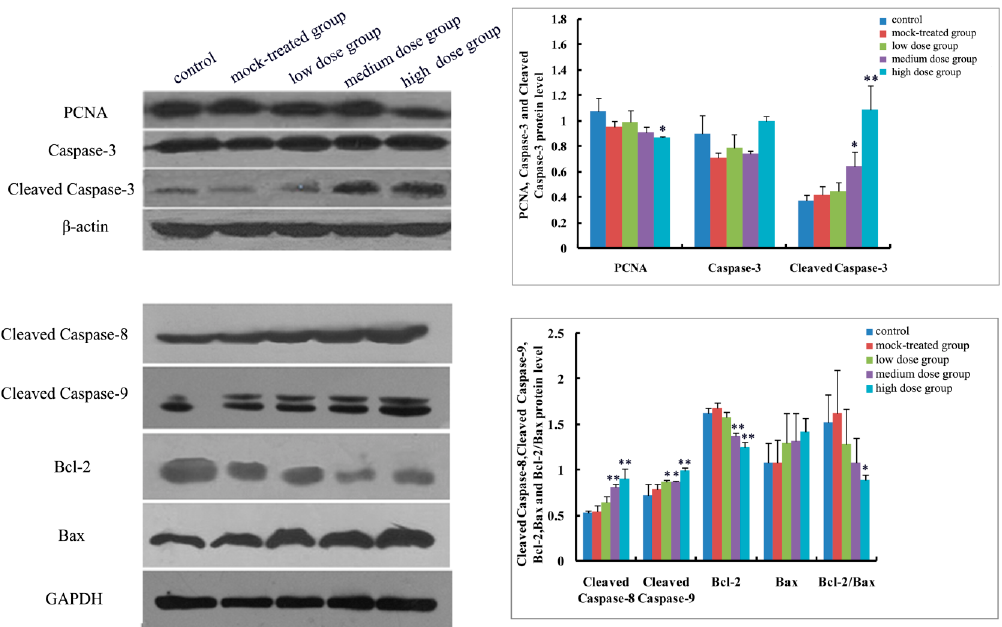
Figure 7. Expressions of apoptosis-related proteins (Caspase-3, Cleaved Caspase-3, Cleaved Caspase-8, Cleaved Caspase-9, Bcl-2, Bax and Bcl-2/Bax) and PCNA in cerebral cortex of mice offspring on postnatal day 14 after maternal exposure to PM 2.5 during pregnancy. Left: the results of western blot; Right: histogram of relative protein levels. * p < 0.05, compared with control; ** p < 0.01, compared with control.